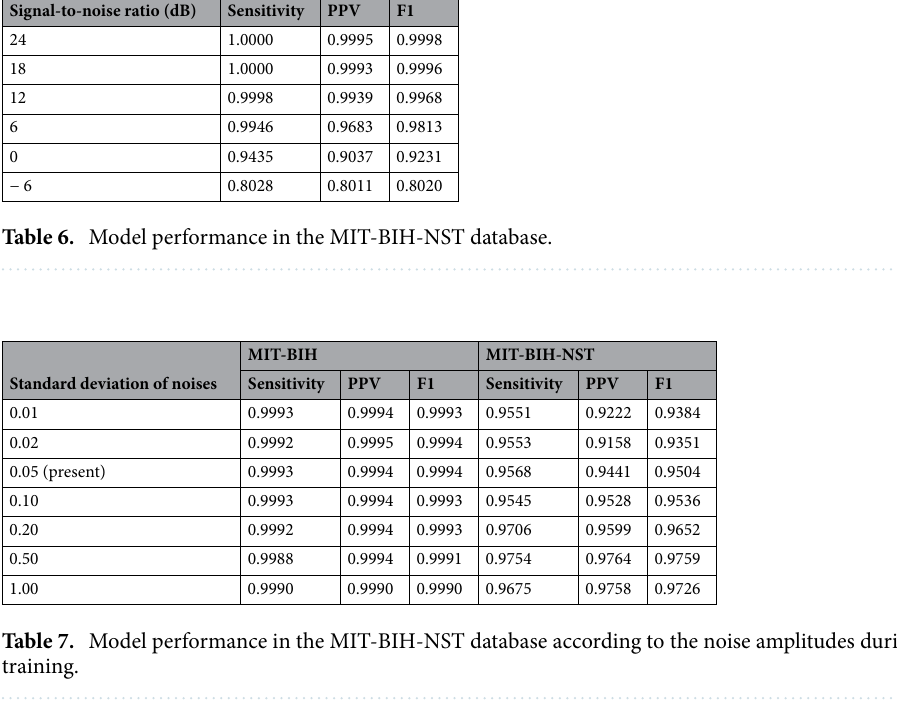
Signal-to-noise ratio (dB)